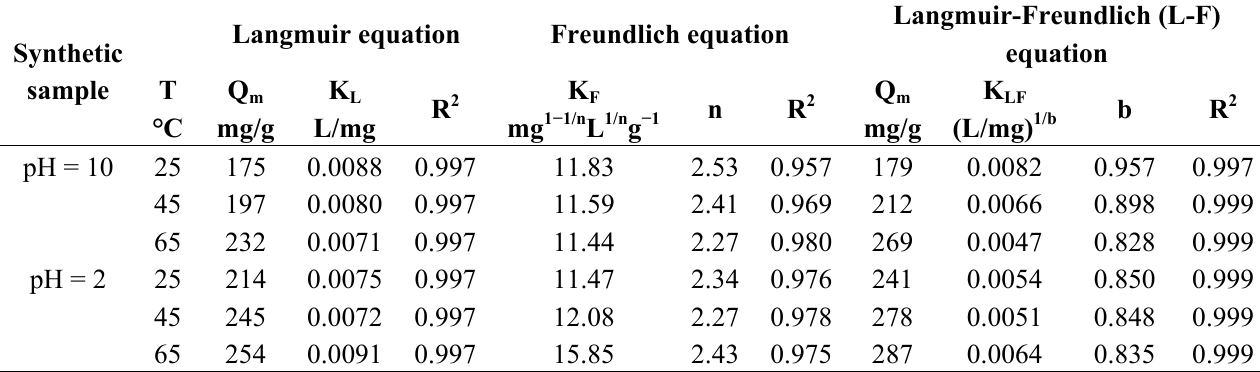
Table 2. Equilibrium parameters for the adsorption of dyes from synthetic effluent